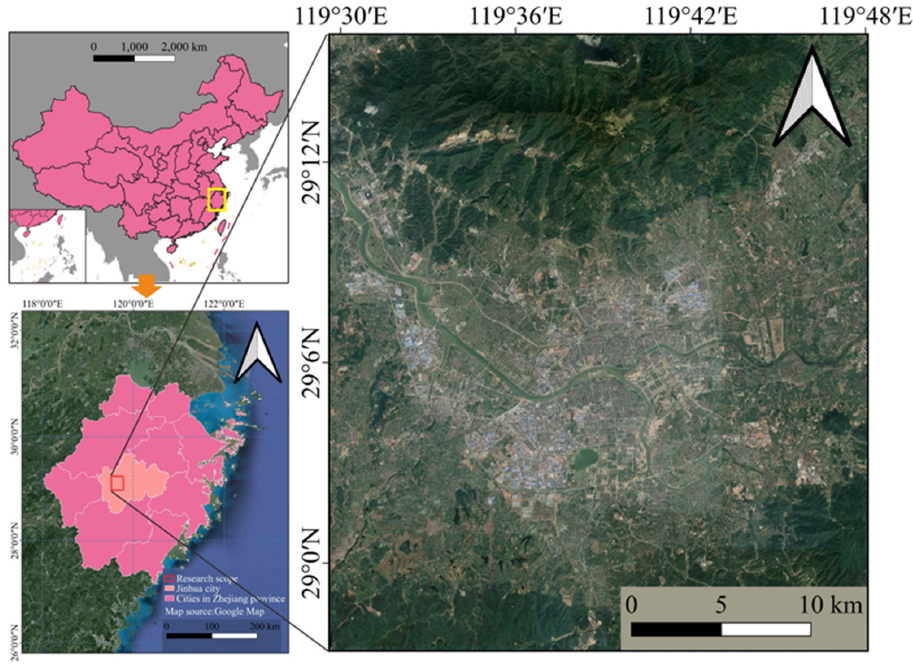
Figure 10. Study area of